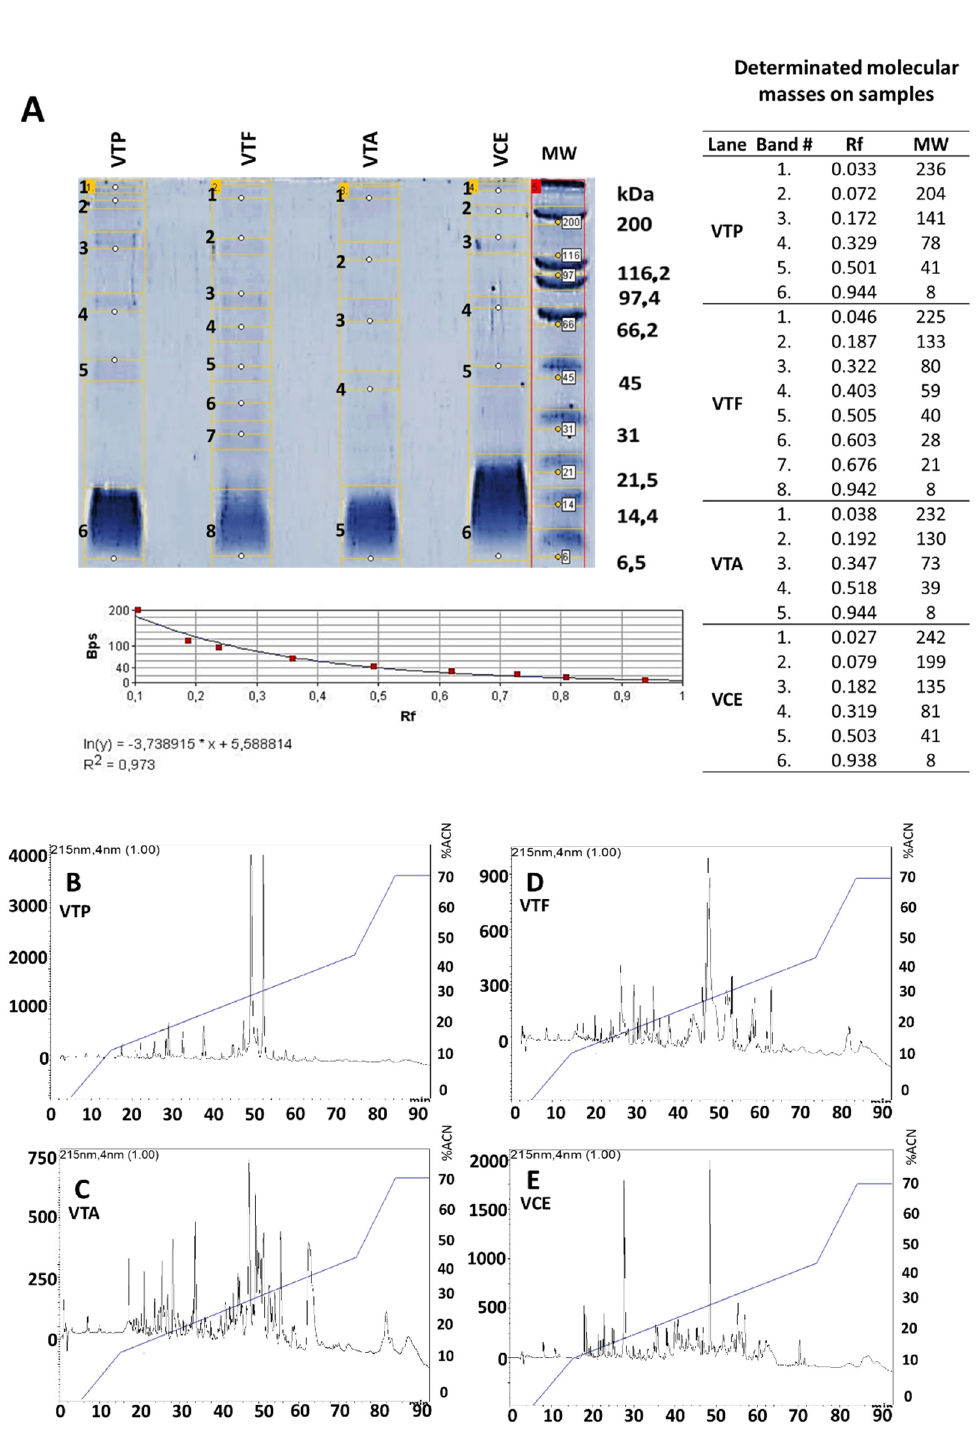
Figure 1. TRIS-TRICINE electrophoresis and chromatographic profile of each batch venom. ( A ) Ten percent TRIS-TRICINE gels loading 1.5 mg/mL of each venom batch. M.W.: Molecular weight. Calibration curve using a simple exponential fit approximation to determine molecular masses on each venom batch. Yellow lines correspond to samples while red line correspond to molecular weight markers. ( B – E ): RP-HPLC chromatographic profiles of the crude venom of all scorpions using a C18 column (250 mm–4.6 mm). Elution gradient used: 0–70% of acetonitrile (99% in TFA 0.1%). The run was monitored at 215 nm. ( B ): Tityus pachyurus venom batch V.T.P. ( C ): Tityus asthenes venom batch VTA. ( D ): Tityus fuhrmanni venom batch VTF. ( E ): Centruroides spp. venom batch V.C.E. The Tityus pachyurus , Tityus asthenes , Tityus fuhrmanii , and Centruroides spp. venom batches LD 50 values used in this study indicate that Tityus pachyurus is the most toxic